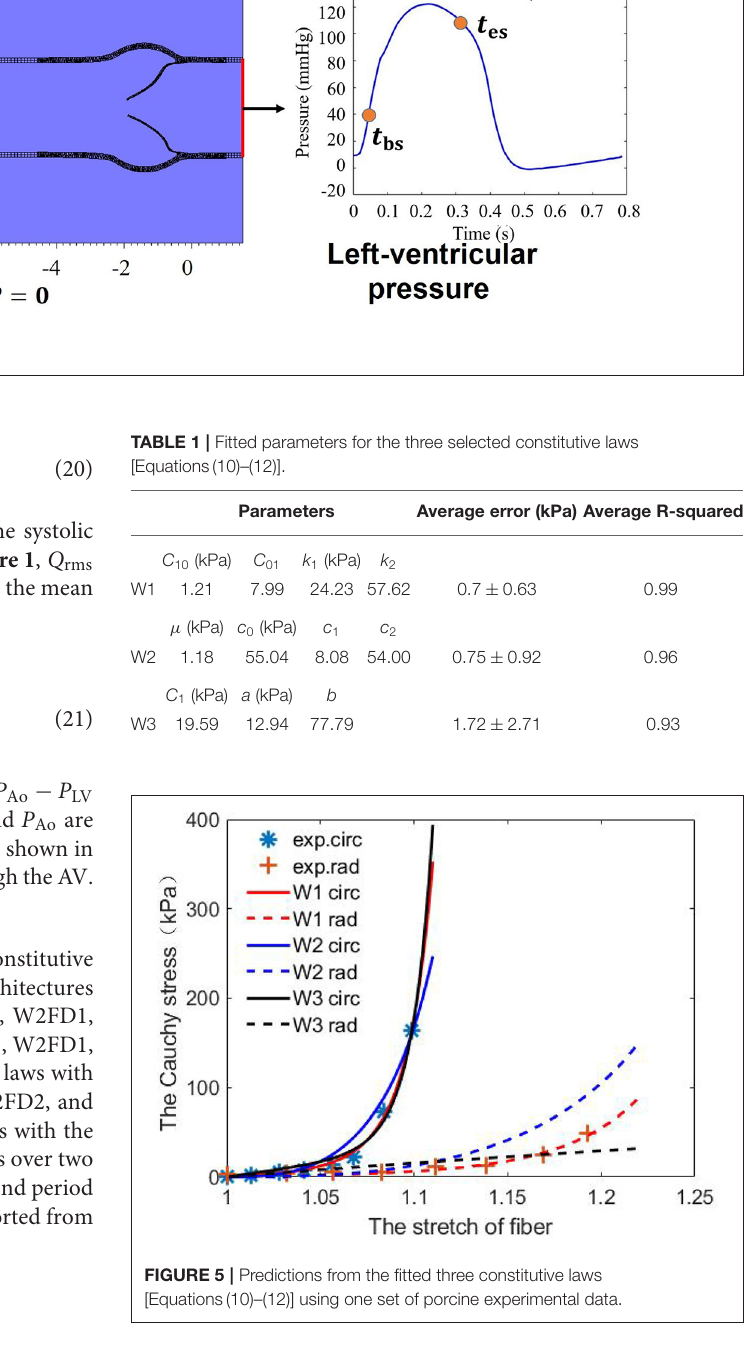
highest R-squared score. While the constitutive law W3 is the poorest because of its incapability of describing the non-linear response along the cross-fiber direction. Figure 5 shows the fitted curves from the three constitutive laws compared to the porcine experimental